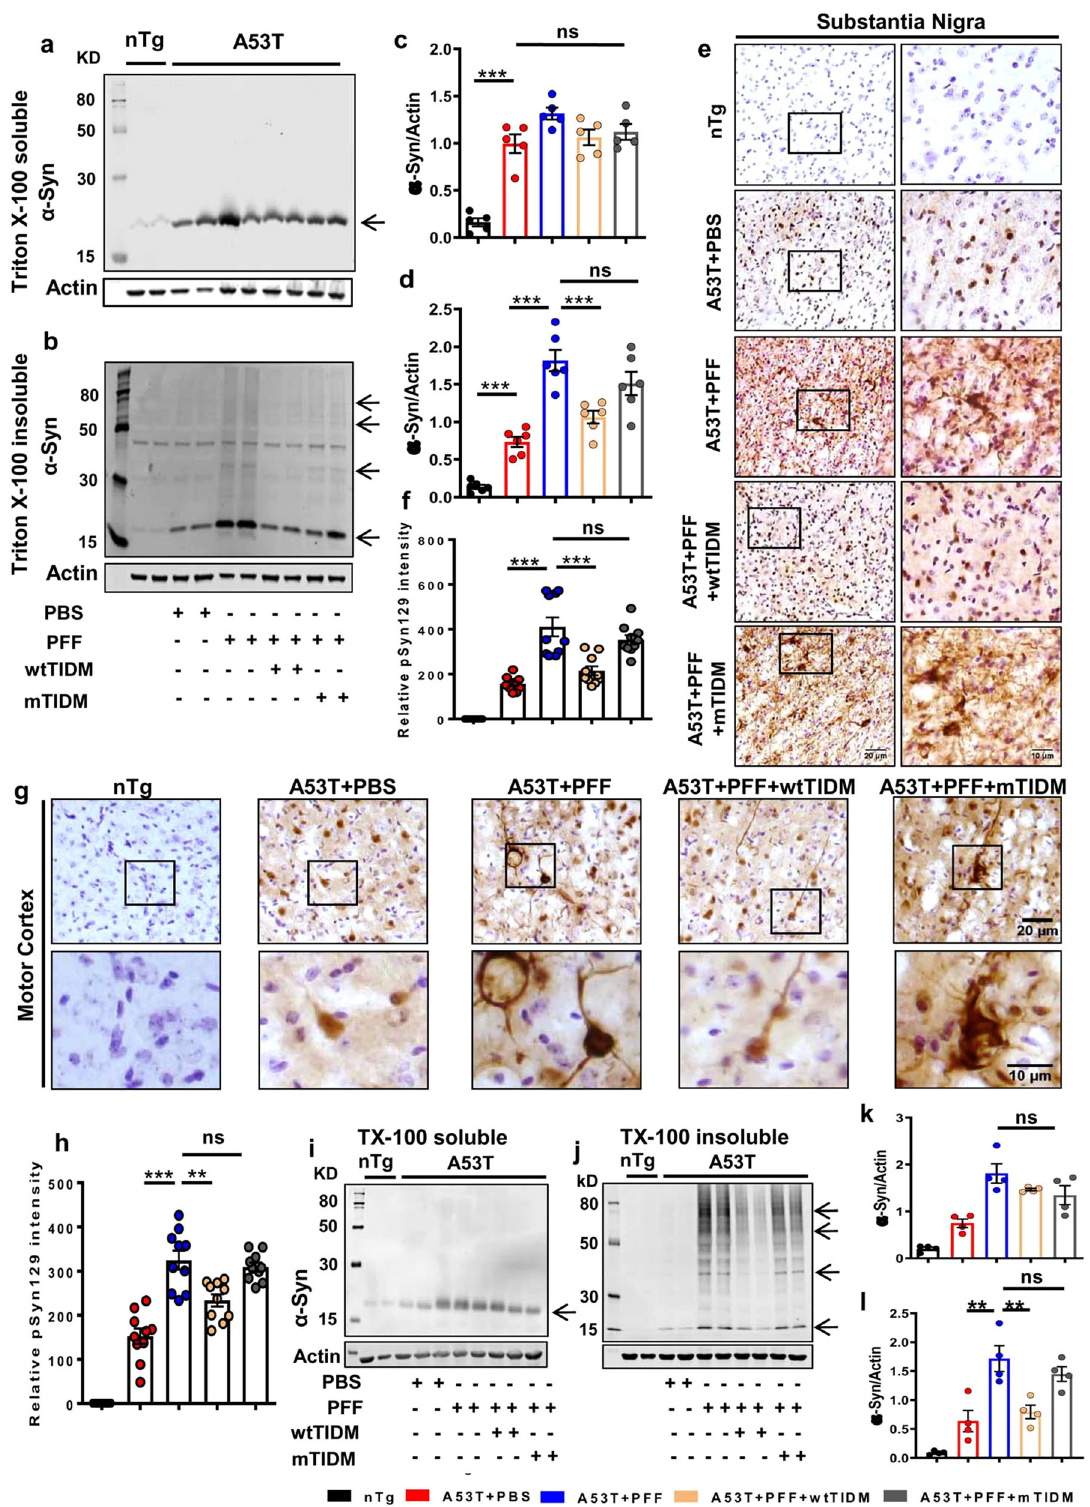
performed. No signi fi cant change in soluble α -syn was found between A53T + PFF and A53T Δ TLR2 + PFF groups (Fig. 3b,